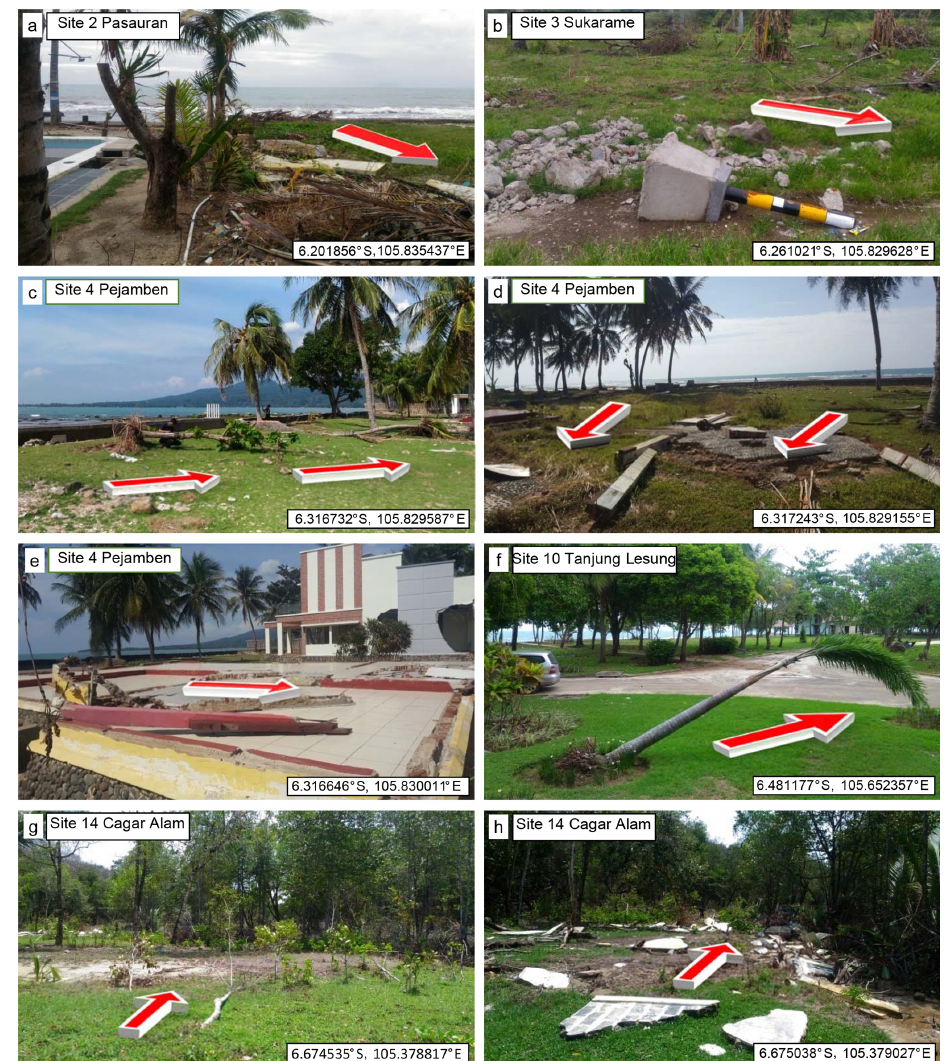
Figure 3. Evidence of tsunami direction. Arrows show the direction of tsunami flow on the ground